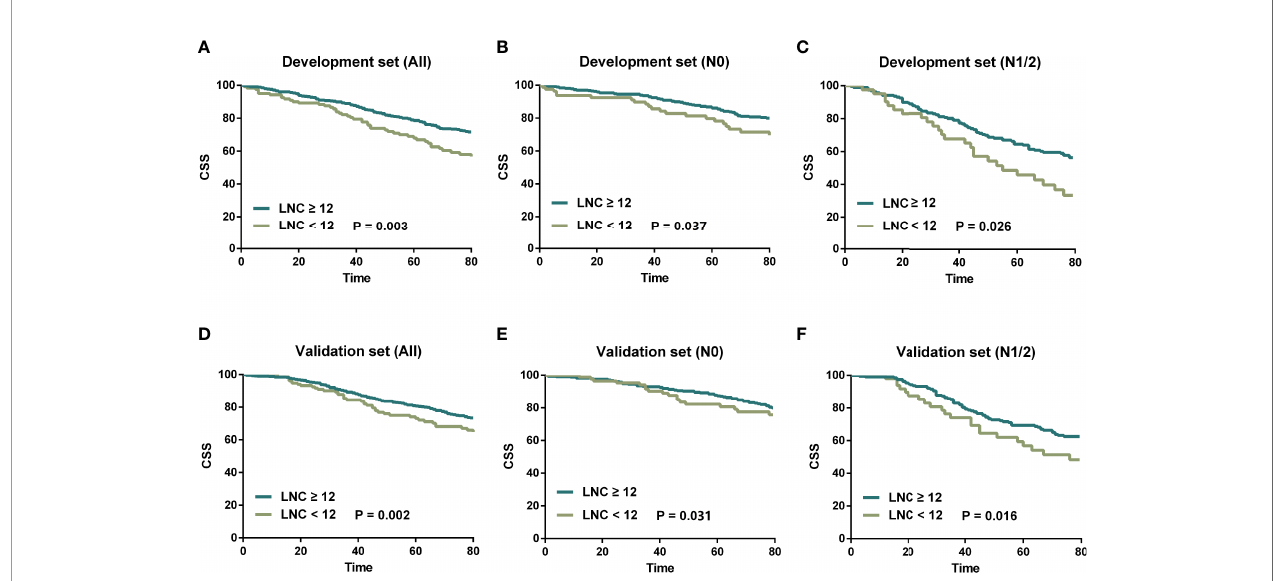
FIGURE 1 | Kaplan – Meier survival curves strati fi ed by LNC ( ≥ 12 vs. <12). (A) LNC ≥ 12 vs. LNC < 12 in the development set. (B) LNC ≥ 12 vs. LNC < 12 for N0 patients in the development set. (C) LNC ≥ 12 vs. LNC < 12 for N1/2 patients in the development set. (D) LNC ≥ 12 vs. LNC < 12 in the validation set. (E) LNC ≥ 12 vs. LNC < 12 for N0 patients in the validation set. (F) LNC ≥ 12 vs. LNC < 12 for N1/2 patients in the validation set.